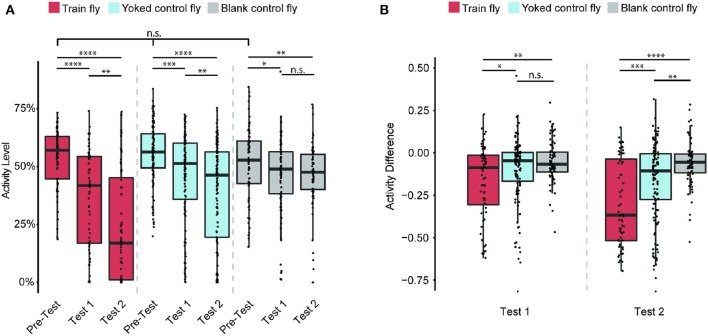
Train flies' continue to show less activity after training ends. Sample size: 64 (Train flies), 125 (Yoked control flies), 72 (Blank control flies). (A) Train, Yoked control, and Blank control flies' activity levels (percentage of time a fly is active during the entire test session) in Pre-Test, Test 1 and Test 2 sessions. During Pre-Test session, all three groups of flies show comparable activity levels during Pre-Test. During each subsequent test session (Test 1 and Test 2), Train flies and Yoked control flies activity levels decreased significantly (Kruskal-Wallis test followed by pairwise Wilcoxon rank sum tests). (B) All three groups of flies' activity difference (AD, the change of activity level shown in A) of Test 1 and Test 2 from that of Pre-Test (i.e., the AD of Test 1 is the activity level of Test 1 minus the activity level of Test 2. To avoid confusion, here we do not use the percentage as the unit). The AD showed that the activity level of Train flies decreases significantly more than that of the two control groups (Kruskal-Wallis test followed by pairwise Wilcoxon rank sum tests). *p < 0.05, **p < 0.01, ***p < 0.001, ****p < 0.0001.